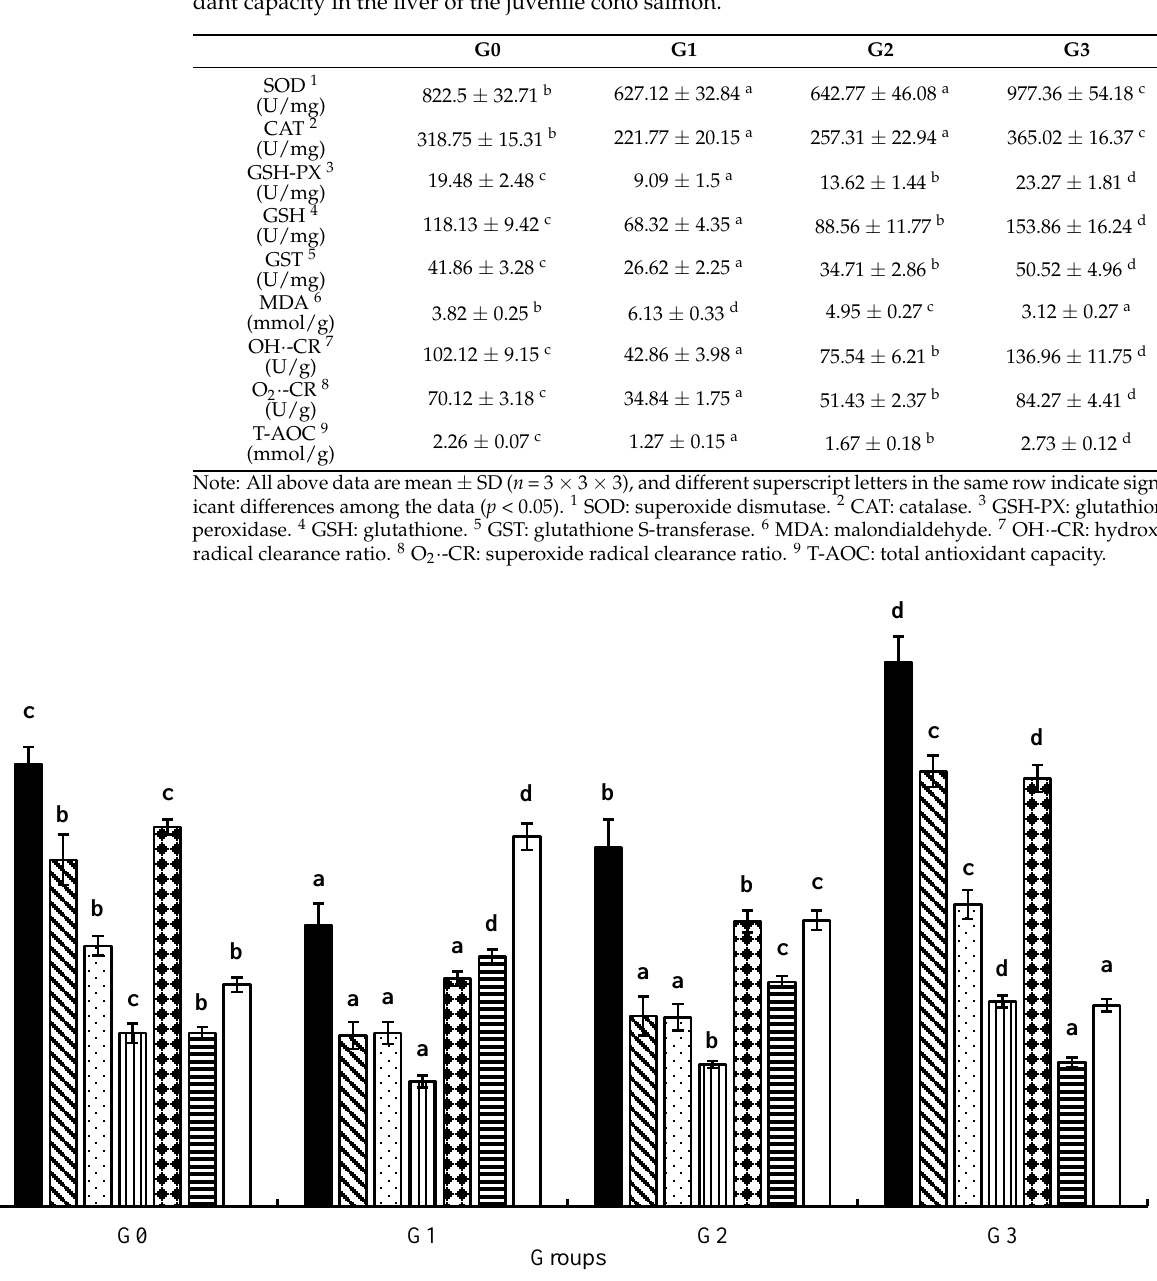
Table 6. Effect of fish meal replaced by unfermented and/or fermented soybean meal on the antioxi- dant capacity in the liver of the juvenile coho salmon.